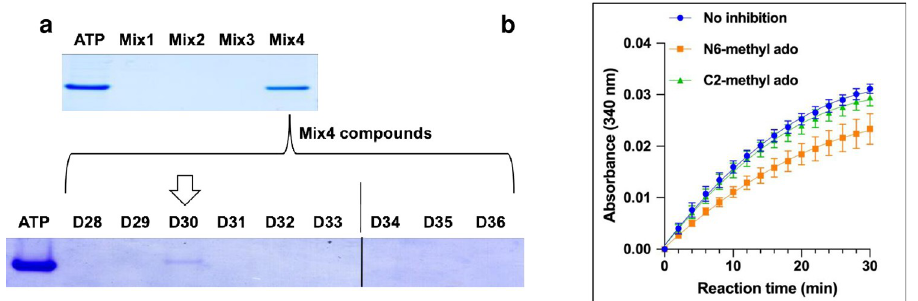
Fig 1. Drug hit identification. (a) DLAC screening tests reveal N6-methyl adenosine (D30) as a putative hit component against AlaDH. D28, C2-methyl adenosine; D29, cyclohexyl 2-[[5-(3,4-dimethoxyphenyl)-1,3,4-oxadiazol- 2-yl]sulfanyl]acetate; D30, N6-methyl adenosine; D31, 4-[[5-(4-methylphenyl)-1,3,4-oxadiazol-2-yl]sulfanyl]but- 2-ynyl furan-2-carboxylate; D32, N-[4-(4-butanoylpiperazin-1-yl)-3-chlorophenyl]-5-nitrofuran-2-carboxamide; D33, 5-(1,3-benzodioxol-5-yl)-N-(5-chloro-2-hydroxyphenyl)-7-(trifluoromethyl)-1,5,6,7-tetrahydro pyrazolo[1,5-a] pyrimidine-2-carboxamide; D34, 5-(4-bromophenyl)-N-[(1,5-dimethylpyrazol-4-yl)methyl]-7-(trifluoromethyl)- 1,5,6,7-tetrahydropyrazolo[1,5-a]pyrimidine-3-carboxamide; D35, 4-methyl-N-(5-pyridin-4-yl-1,3,4-oxadiazol-2-yl) benzamide; D36, benzyl (2S)-4-methyl-2-[[4-[(3-methylphenyl) carbamoyl]-1H-imidazole-5-carbonyl]amino] pentanoate. The gels are cropped from the full-length gels which are presented in S2a and S2c Fig in S1 File . ATP is used as a positive control based on our previous data [25], where NADH and ATP (but not NAD) bound strongly with this assay (b) Inhibition effect of N6-methyl adenosine is confirmed using enzyme kinetic